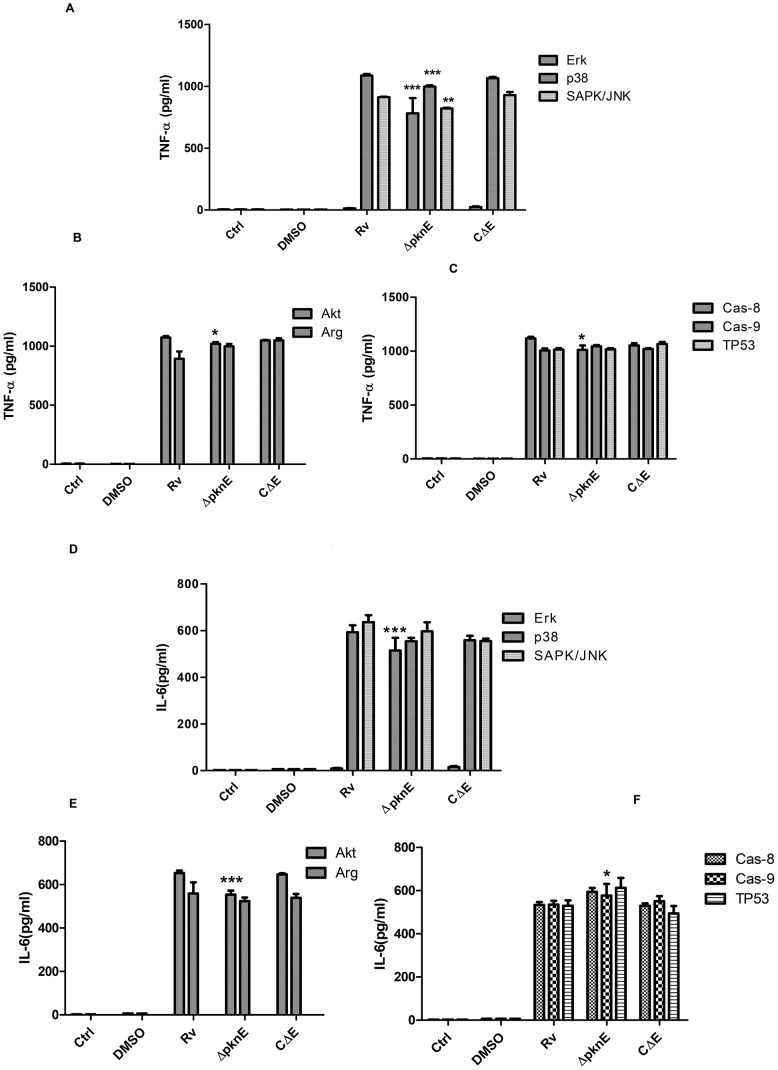
The secretion of TNF-α and IL-6 in ΔpknE infected macrophages is modulated by intracellular signaling.Culture supernatants post infection in the presence of inhibitors TNF-α [A) MAPK family, B) survival family and C) caspase family] and IL-6 α [D) MAPK family, E) survival family, and F) caspase family ] was analyzed using ELISA on day 1. The error bars represent standard error of the means. Data is from three independent experiments. The symbols *, **, *** denotes p<0.05, p<0.001 and p<0.0001(one way ANOVA) respectively, when ΔpknE was compared to Rv infected macrophages.